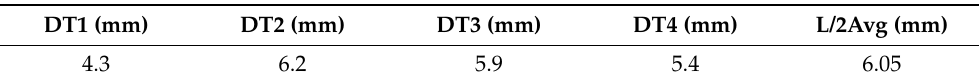
Table 6. Vertical displacement when introducing prestressing to the strands (DT: displacement transducer).